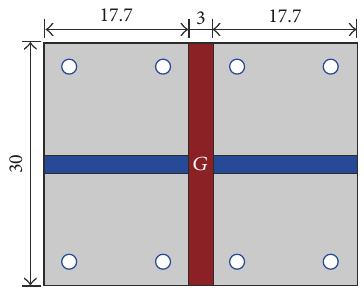
Figure 3: The structure of the reflect standard.